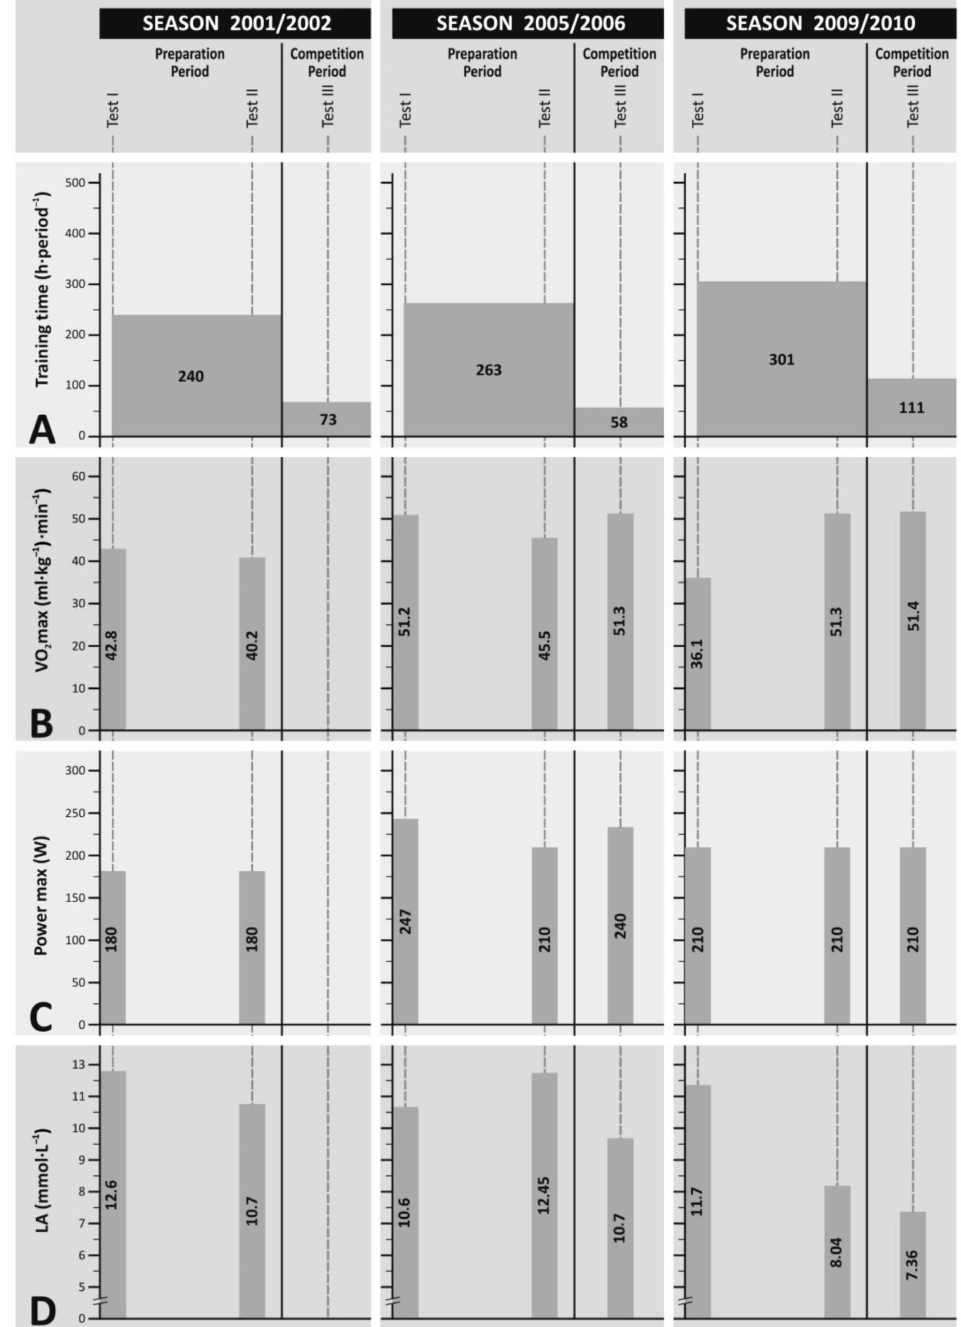
Figure 1. Training time represents the total amount of time spent on training in a given periods in varied seasons (2001/2002, 2005/2006, 2009/2010) and periods (Preparation Periods, Competition Period) with regard to the best results of selected variables obtained during a respective exercise tests. ( A ) Training time (h). ( B ) VO 2max (mL · kg − 1 · min − 1 ). ( C ) Power output (W). ( D ) Blood lactate concentration (mmol · L − 1